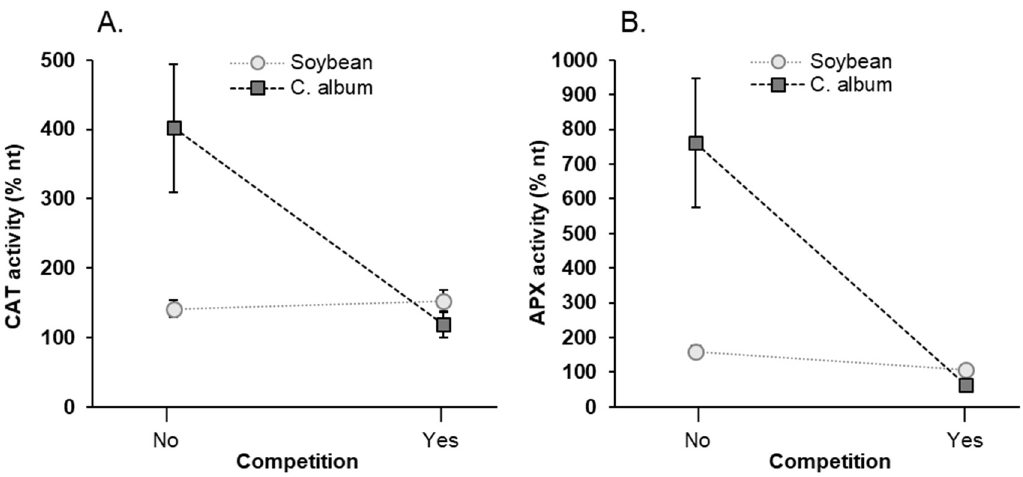
Figure 9. Species-competition interaction for average catalase (CAT) activity ( A ) and average ascorbate peroxidase (APX) activity ( B ) in fresh leaves of soybean and C. album , expressed as percentage of salt-treated samples over non-treated samples (% nt). Values on the left refer to plants grown in single-species tanks (no competition). Values on the right refer to plants grown in mixed-species tanks (competition between soybean and C. album ). Vertical bars denote the standard error.